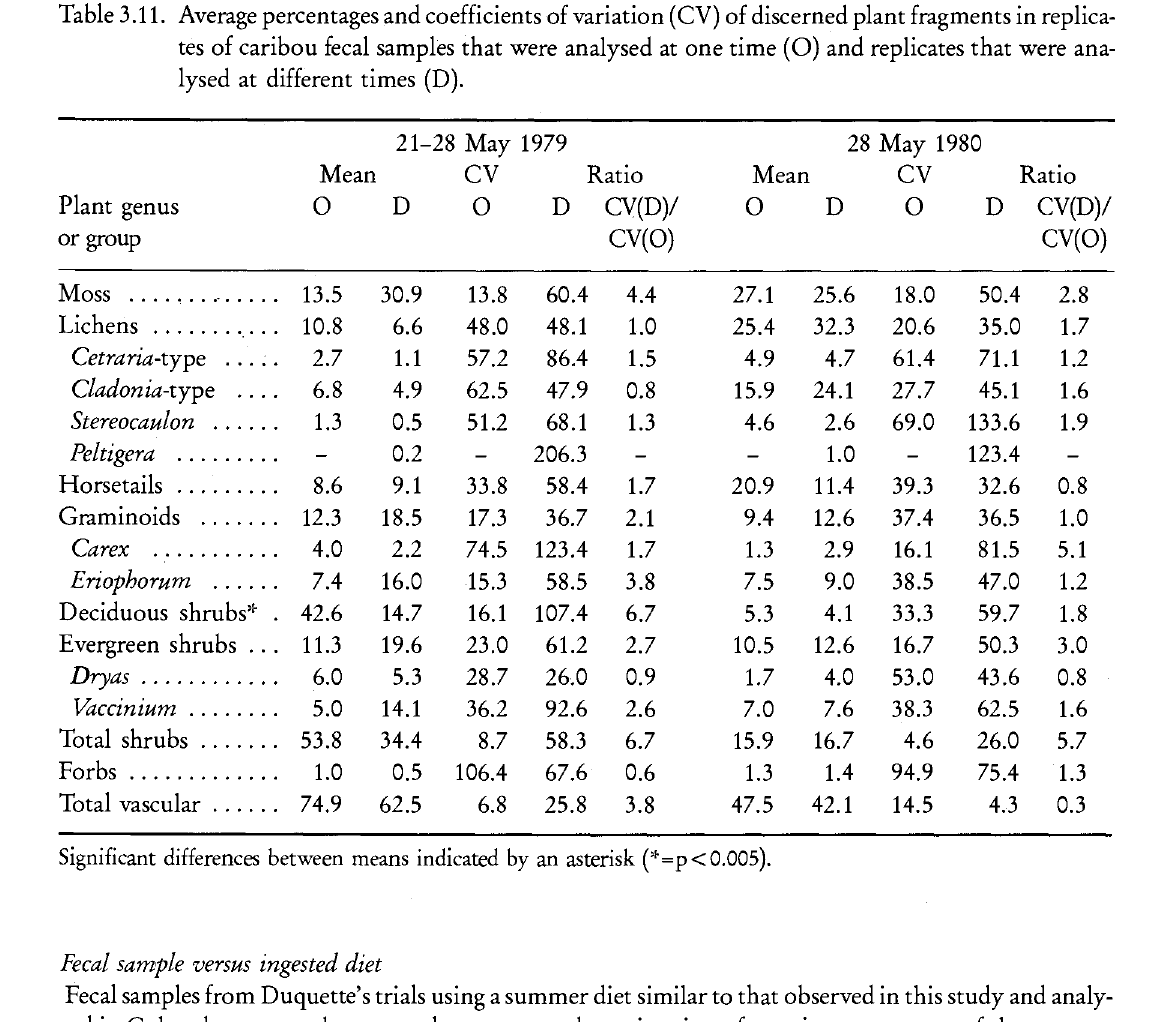
Table 3.11. Average percentages and coefficients of variation (CV) of discerned plant fragments in replica tes of caribou fecal samples that were analysed at one time (O) and replicates that were ana lysed at different times